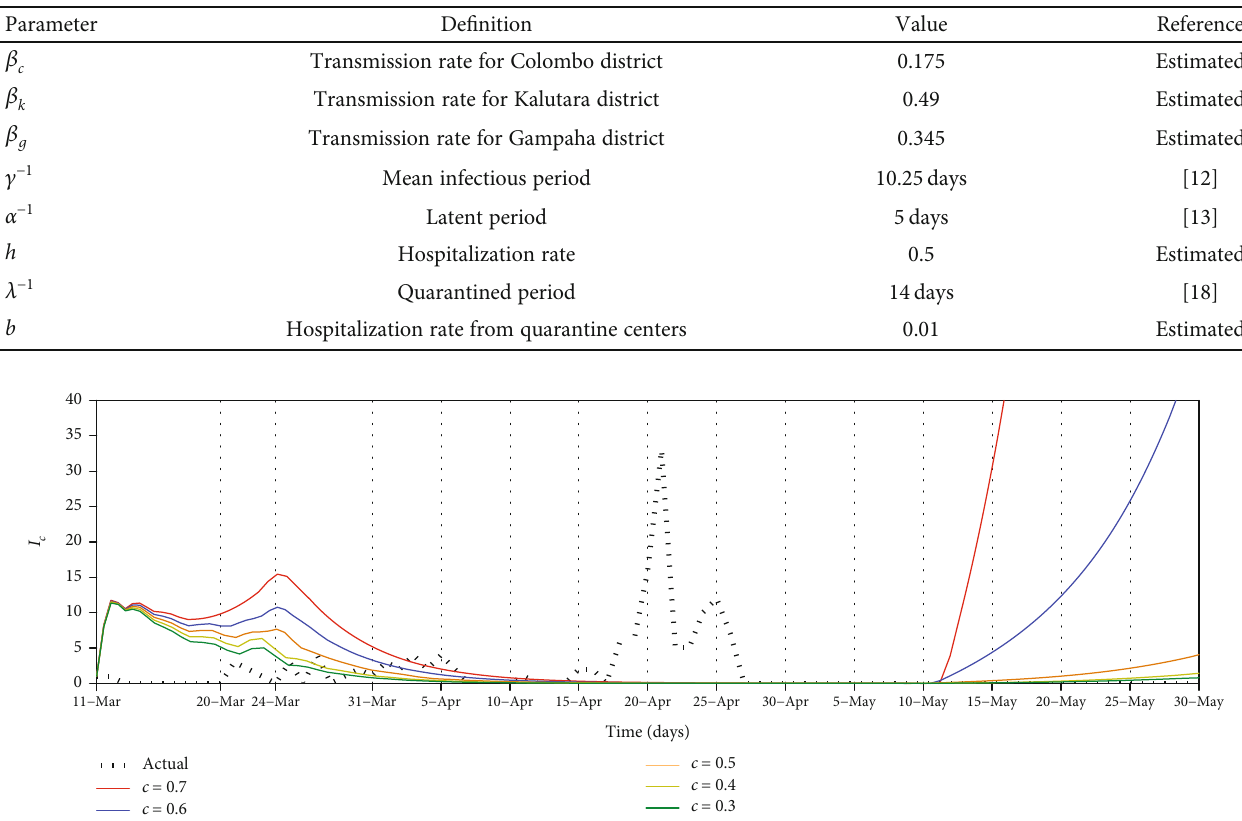
Figure 2: Comparison of actual infected data and simulation results for di ff erent contact rates in Sri Lanka from 20 th March to 24 th March. Table 1: Descriptions and values of all parameters used in the model simulation.